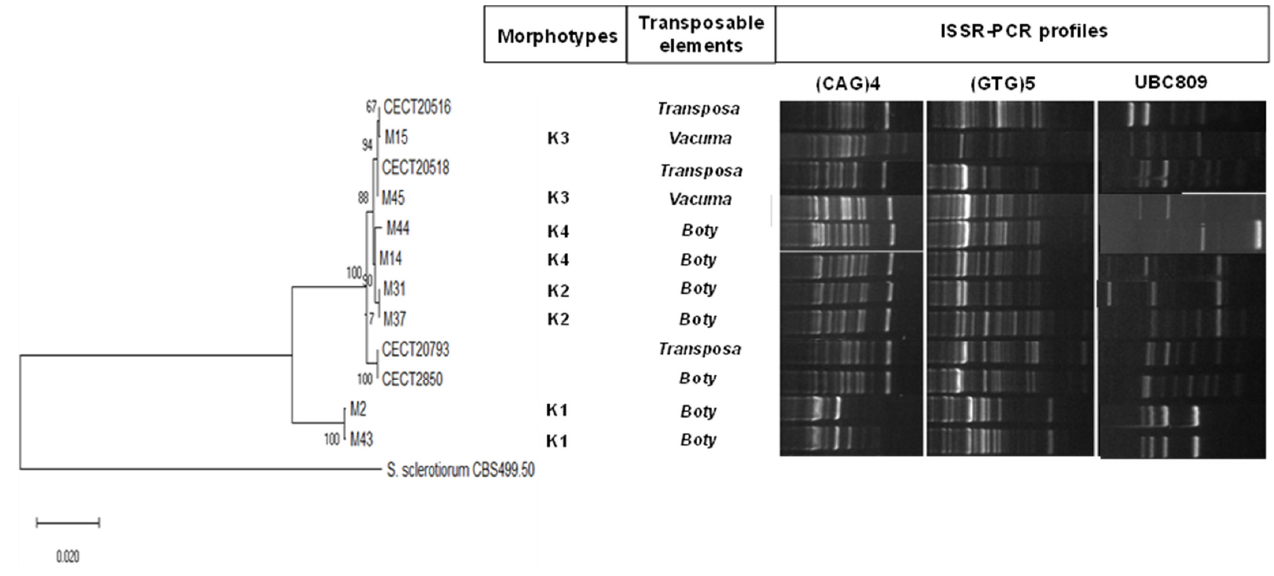
Figure 5. Analysis of the genetic variability of the four morphotypes utilising phylogenetic tree inferred by using the maximum likelihood method and Tamura–Nei model constructed with the concatenated sequences of ITS1-5.8S rDAN-ITS4 + LSU 26S rDNA+ calmodulin gene + β -tubulin of Botrytis cinerea morphotypes and type strains (the percentage of trees in which the associated taxa clustered together is shown next to the branches); detection of the transposable elements Boty and Flipper was registered as Vacuma (absence of transposable elements), Boty (presence of Boty element alone), and Transposa (presence of Boty and Flipper elements); and ( C ) ISSR profiles obtained with (CAG) 4 , (GTG) 5 , and UBC809. Table 2. Effect of combined inoculations of bacteria, moulds, and yeasts isolated from cherries with ‘aqueous spot’. Inoculation Combinations Symptoms a Disease Incidence (%) Mould